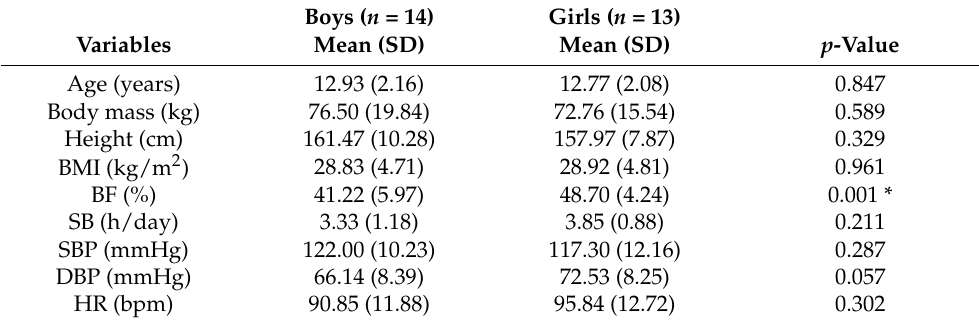
Table 1. Characterization of adolescents with overweight/obesity according to sex.